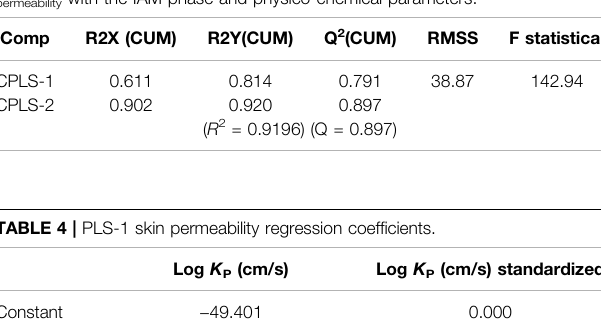
TABLE 3 | Statistical parameters of the PLS model resulting from OSC log K P skin permeability with the IAM phase and physico-chemical parameters.